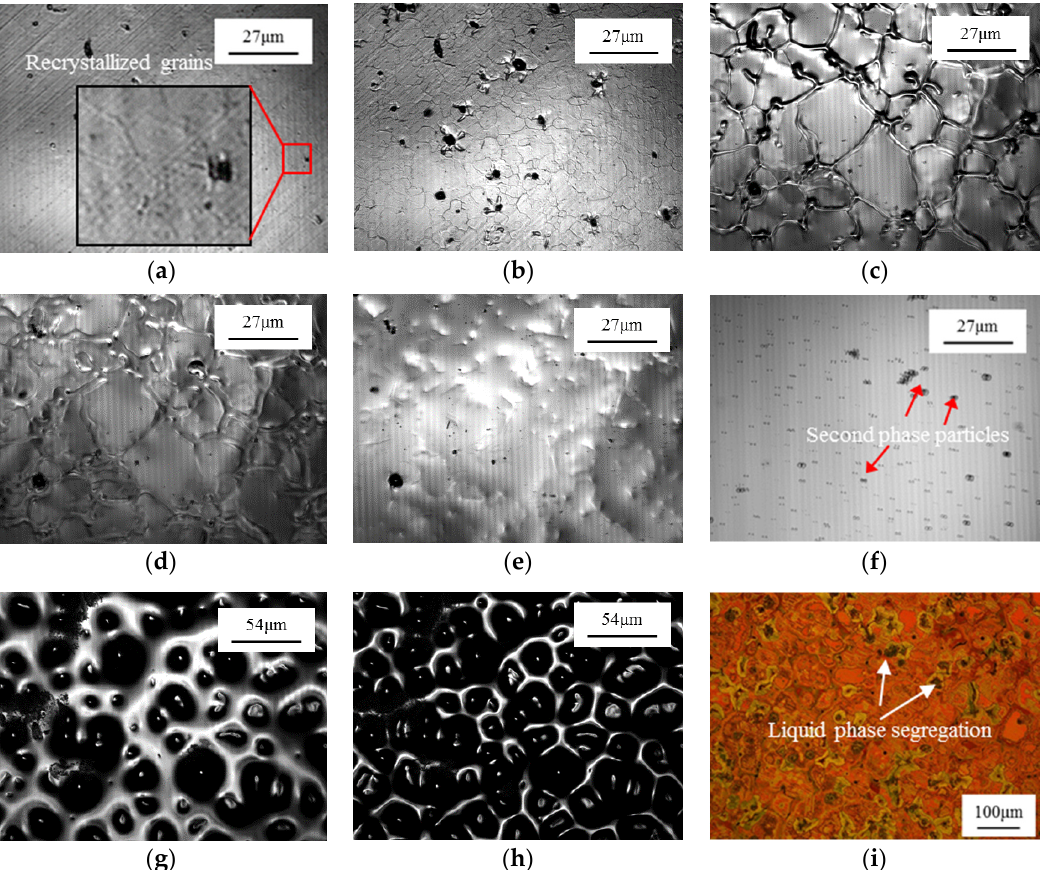
Figure 3. In situ HT-CLSM microstructural observations of as-received C5191 alloy during thermal cycle (Figure 1b) at different temperatures: ( a ) 645.7 °C, ( b ) 700.1 °C, ( c ) 890.1 °C, ( d ) 893.5 °C, ( e ) 895.9 °C, ( f ) 939.5 °C, ( g ) 878.9 °C, and ( h ) 873.5 °C; ( i ) optical image of solidified microstructure.